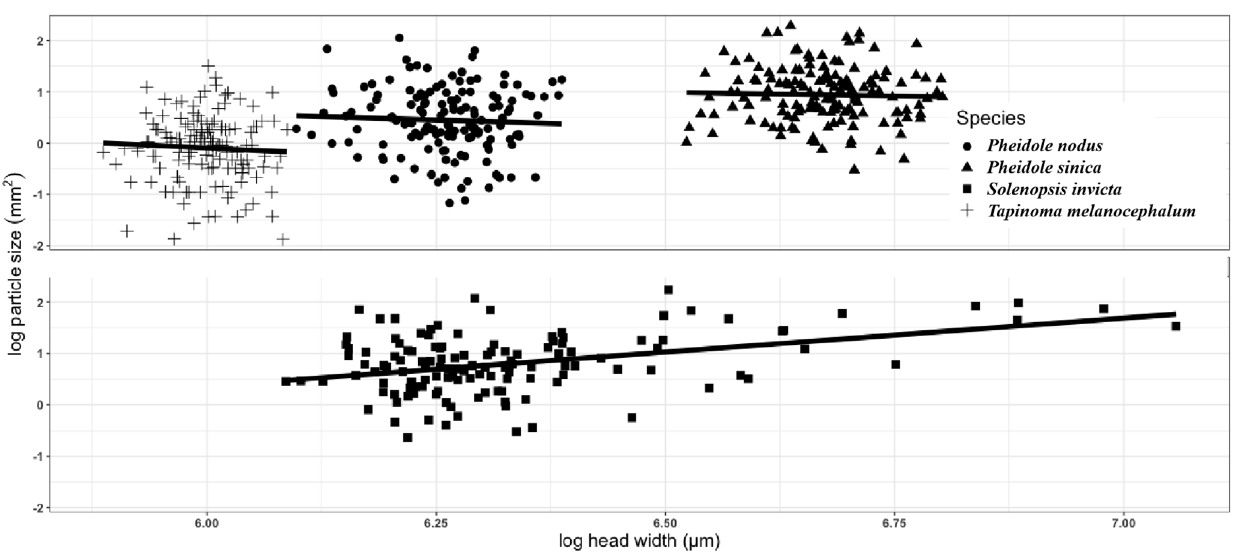
Figure 4. Correlation between head width and the particle size for Solenopsis invicta , Pheidole sinica , Pheidole nodus , or Tapinoma melanocephalum . The black line indicates correlation line. Table 6. Results of linear regression models with particle size as dependent variable and ant head width as independent variable for each